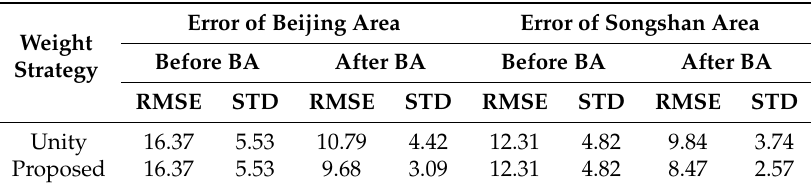
Table 3. Comparison of residual errors with different weight strategies (m). (BA is the abbreviation of control point free block